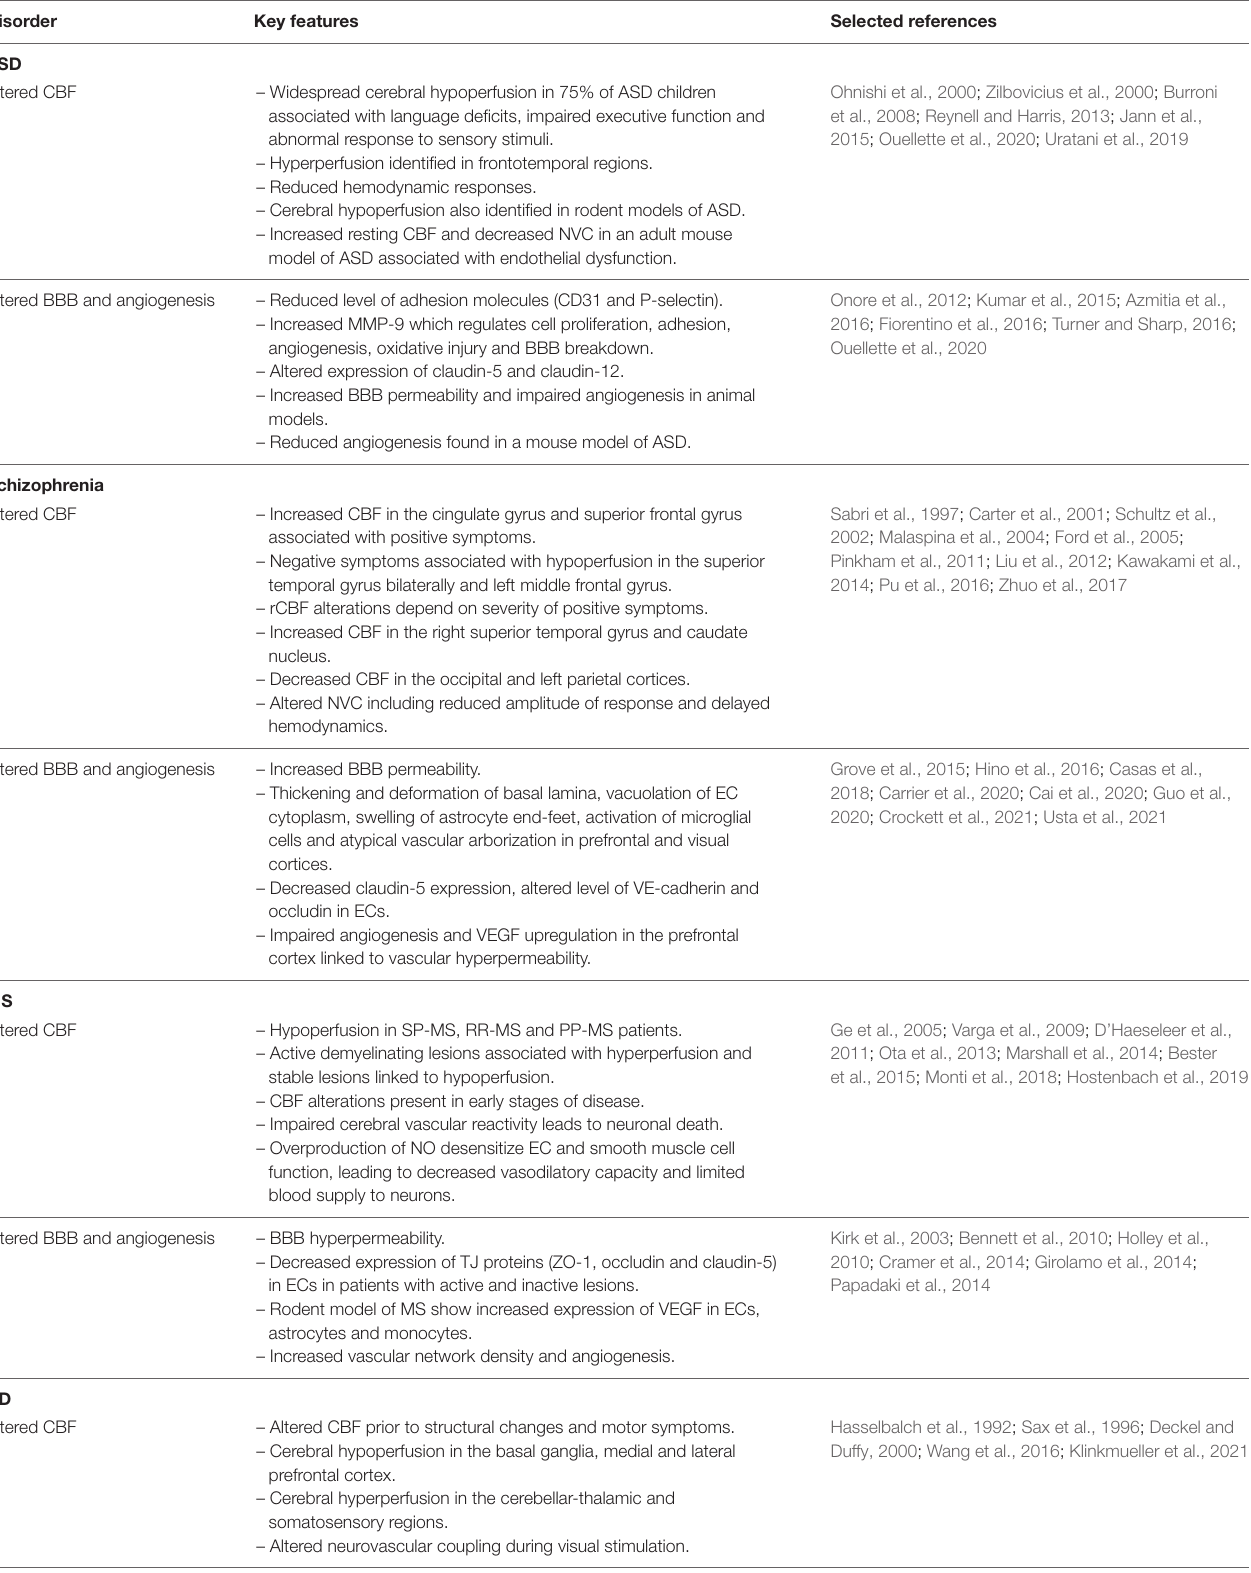
TABLE 1 | Major altered features associated with CBF, BBB, and angiogenesis in neurodevelopmental and neurodegenerative